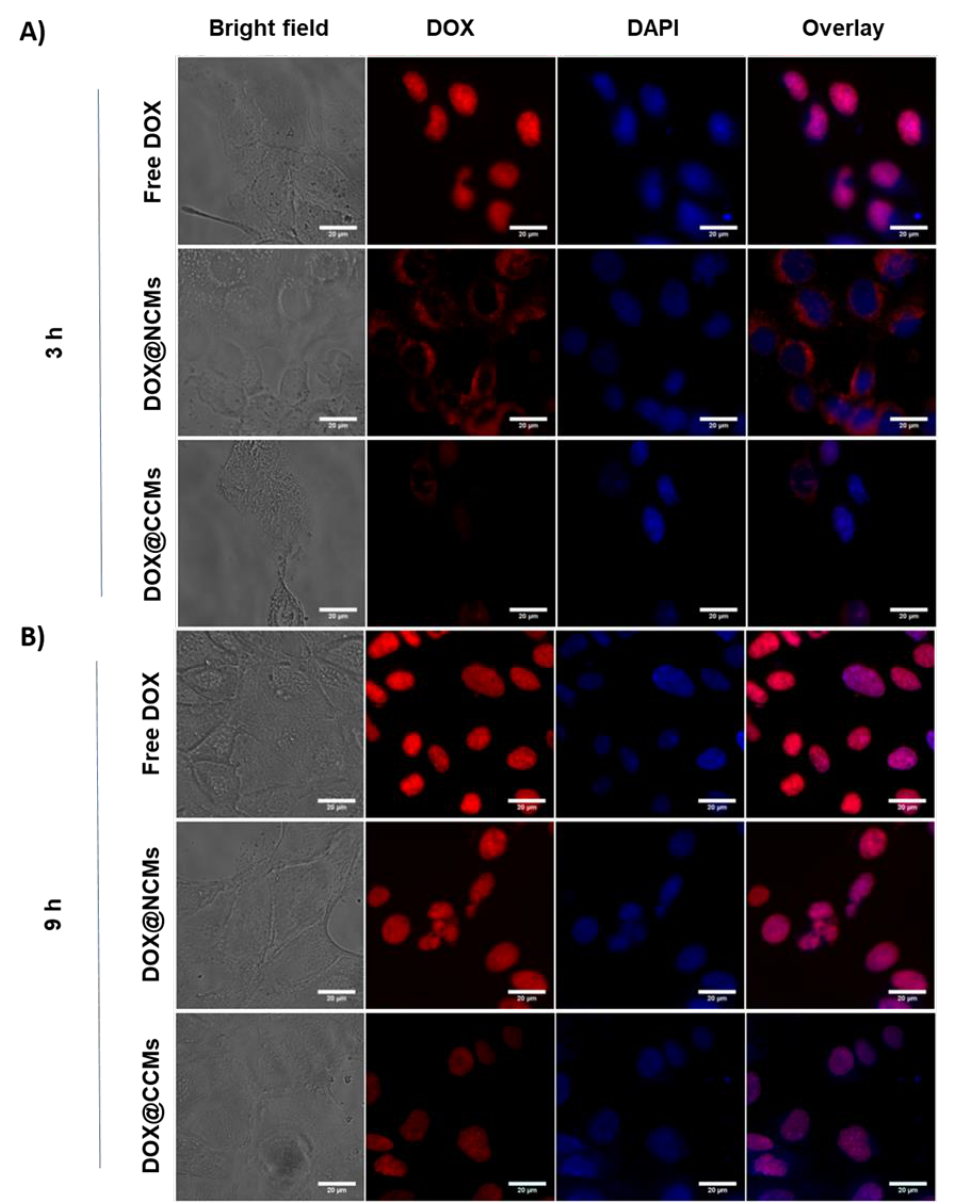
Figure 7. Fluorescence microscope images of HeLa cells incubated with 3 µg/mL DOX, DOX@CCMs, and DOX@NCMs for 3 h ( A ) and 9 h ( B ). The scale bar represented 20 µm.